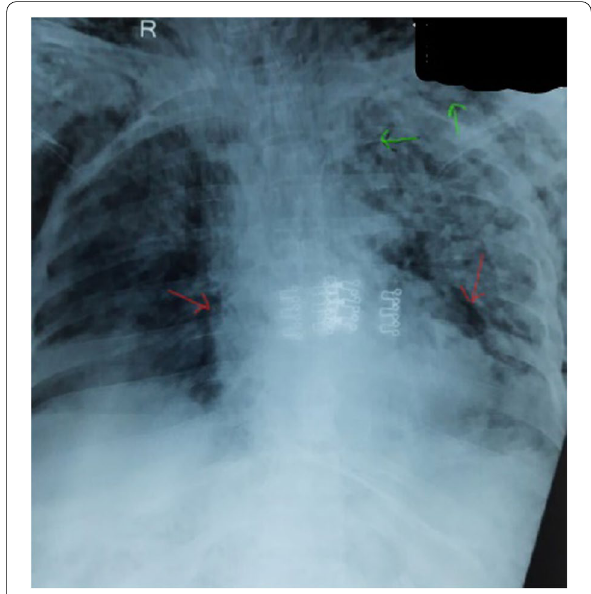
Fig. 3 CXR showing pneumomediastinum (red arrows) with subcutaneous emphysema (green